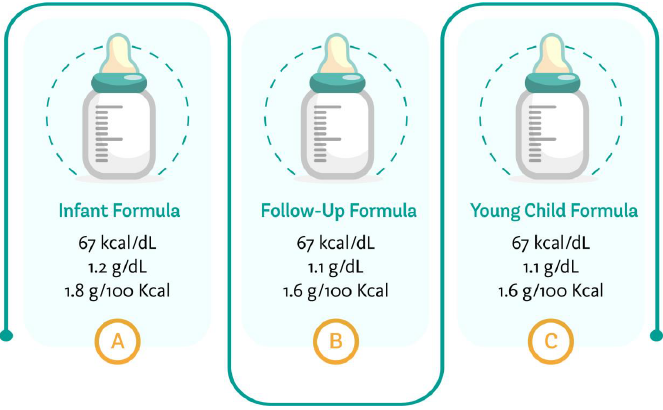
Figure 1. Average energy and minimum protein content of formulae targeting different age groups. Author’s creation,